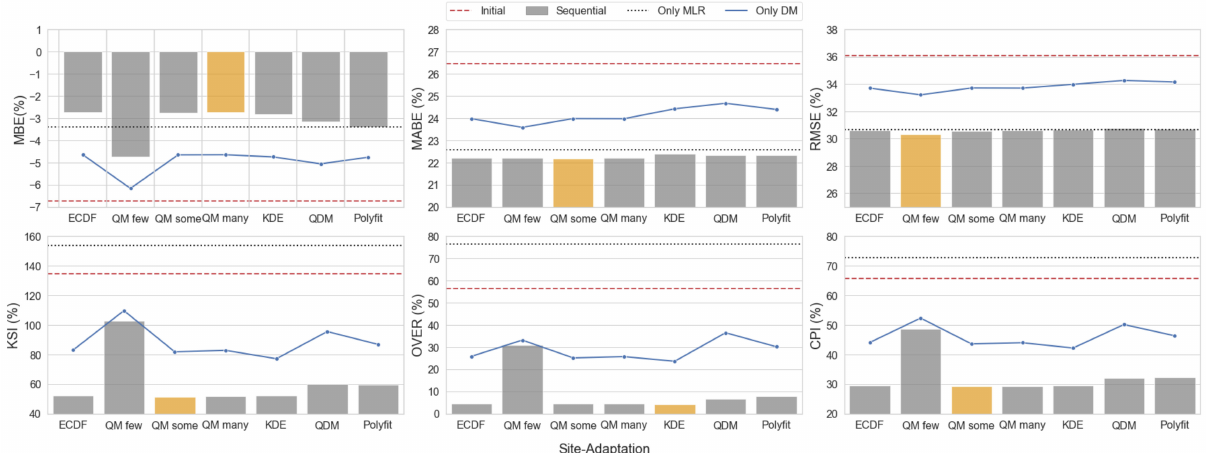
Figure 6. Comparison between sequential methods, MLR, and individual distribution mapping techniques for the site adaptation of GHI in cloudy-sky conditions. The orange bar indicate the best performing sequential method.